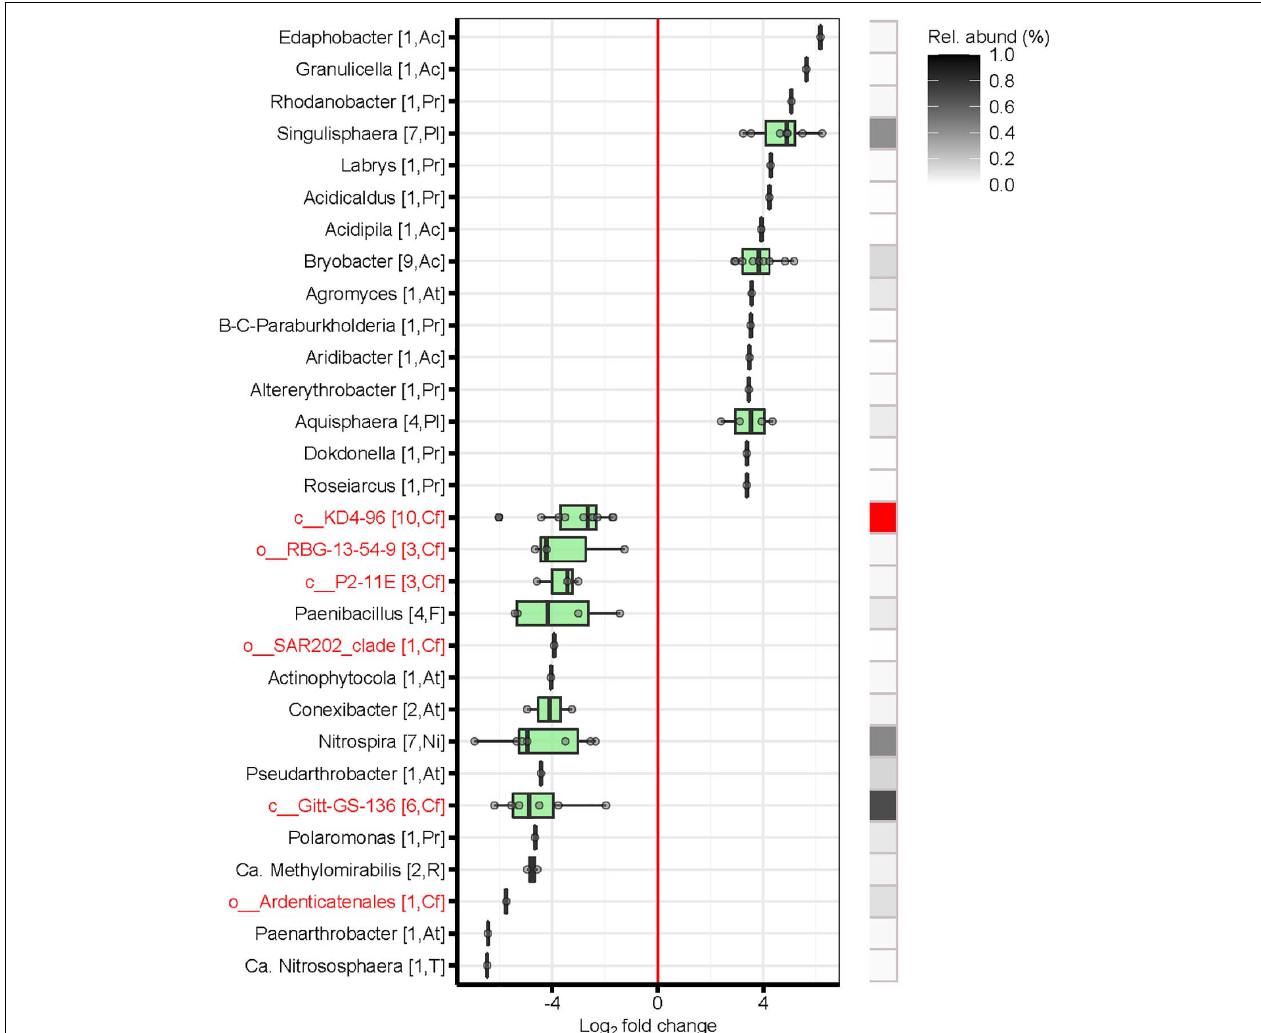
FIGURE 5 | Differentially abundant bacteria genera of topsoil (soil layers L1 and L2) vs. subsoil (soil layers L5 and L6). Shown are only significant log 2 -fold changes (LFC) of genera based on a significance level of p < 0.01 after false discovery rate correction. Error bars represent standard deviation. Positive LFC values indicate a higher occurrence of the taxa in the topsoil, whereas negative LFC indicate a higher occurrence in the subsoil. Only 30 genera with the highest (positive) and lowest (negative) mean LFC values were represented. The number of differentially abundant OTUs comprised in each genus, and the phyla to which they belong are indicated in brackets. Poorly known taxa are highlighted in red. Relative abundance (%): sum of the abundance of the differentially abundant OTUs belonging to the same genera as a percentage of the total number of sequences across the compared soils. Relative abundance depicted in red exceeds the abundance scale.